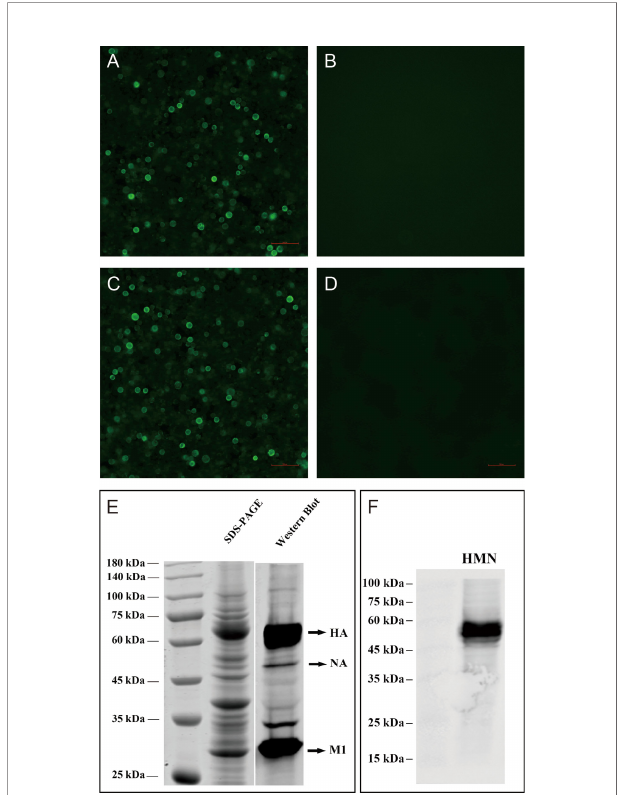
FIGURE 1 | Characterization of H7N9 VLPs and HMN by indirect immuno fl uorescence assay (IFA), SDS-PAGE, and Western blotting. IFA detection of expression of the baculovirus in sf9 infected cells. Sf9 cells infected with rBV-HA, rBV-NA, and rBV-HA (A) , rBV-HMN (C) , or only empty baculoviruses (B) , (D) after 48 h. H7N9 chicken antiserum and anti-His-tag mouse monoclonal antibodies were used in the IFA assay. (E) The expression of the HA, NA, and M1 proteins on the VLPs was analyzed using SDS-PAGE gels with Coomassie blue staining and validated by Western blot using the anti-His-tag mouse monoclonal antibody. The molecular mass of H7N9 HA, NA, and M1 were ~70, ~55, and ~28 kDa, respectively. (F) The expression of HMN protein was validated by Western blot using the anti-His-tag mouse monoclonal antibody. The molecular mass of HMN was ~52